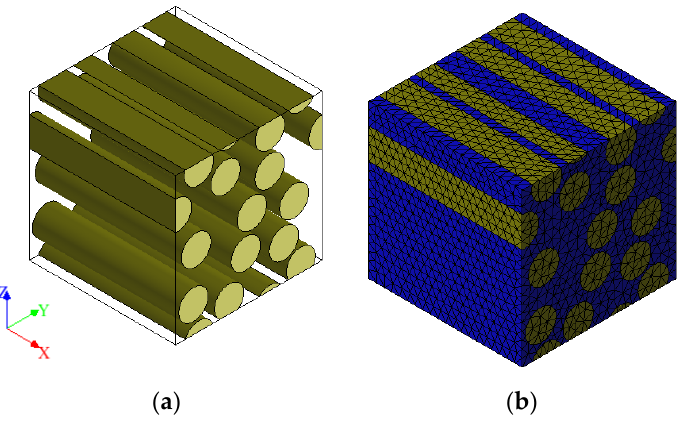
Figure 10. RVE geometry for ( a ) 3D aligned fiber, and the ( b ) tetrahedral mesh using Digimat-FE. Table 4. Number of elements and effective volume fraction of fiber and matrix of meshing.